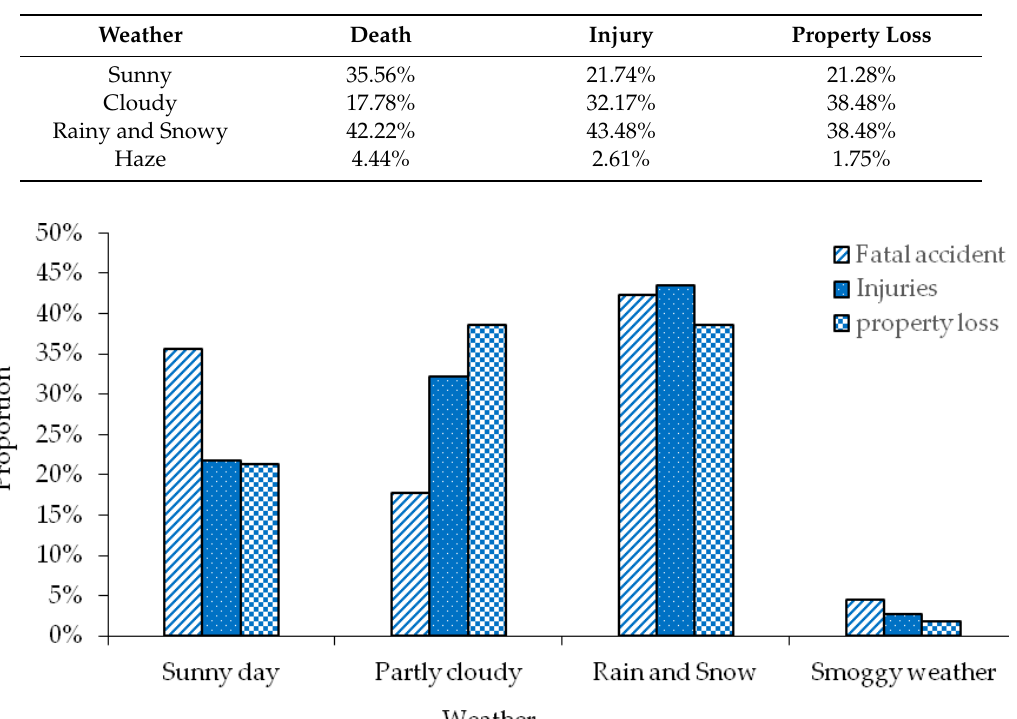
Table 5. Proportion of tra ffi c accidents with weather sub-independent variables.